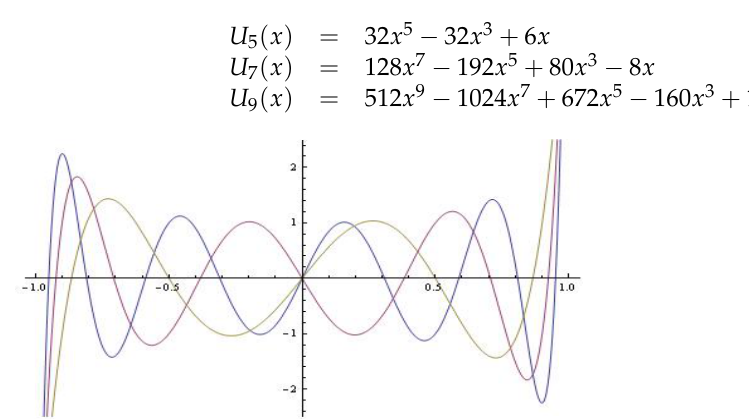
Figure 1. U n ( x ) for n = 5, n = 7 and n = 9.